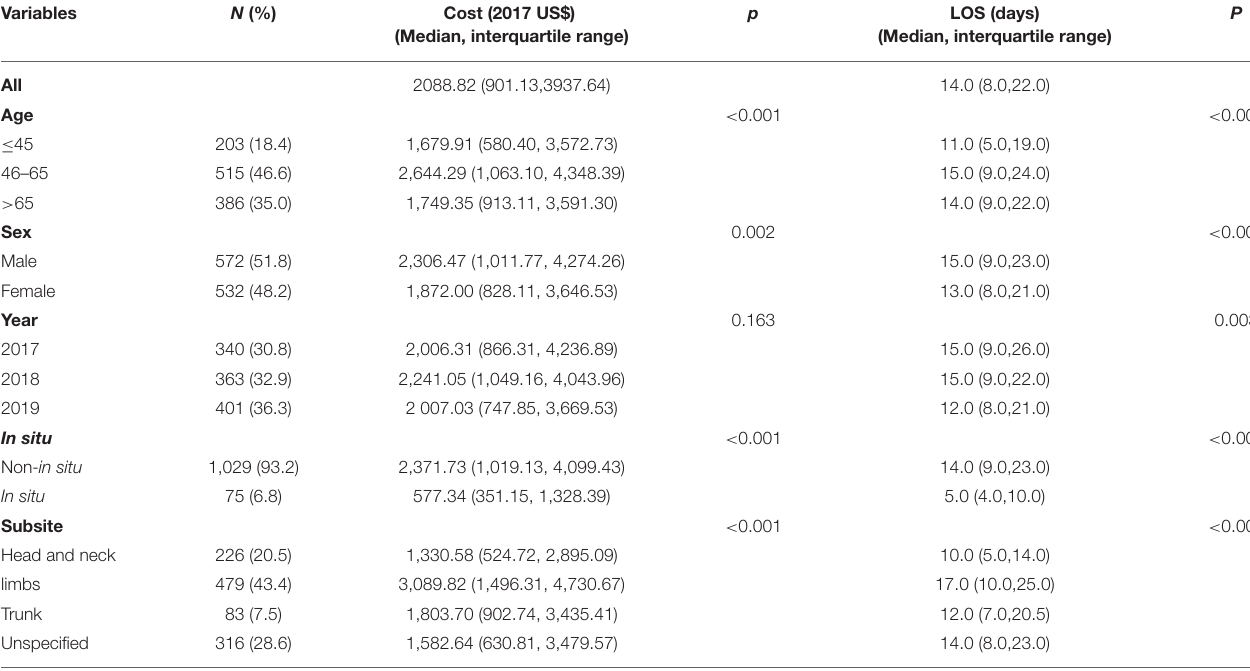
TABLE 2 | Baseline characteristics of melanoma patients undergoing surgery in Hunan during 2017–2019. Variables